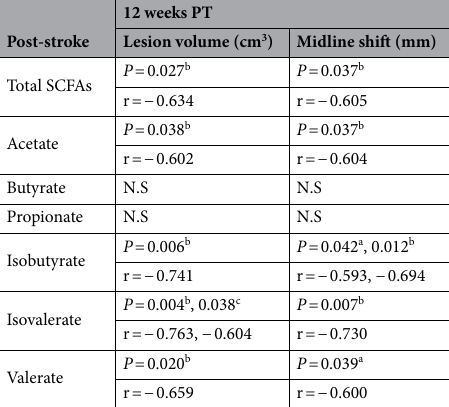
Table 2. Correlations between post-stroke changes in fecal SCFAs levels and lesion volume and midline shift changes 12 weeks post-treatment. Time point of fecal SCFAs showing significant correlation: a = Acute 1, b = Acute 2, c = Subacute, d = Chronic. r = Pearson correlation